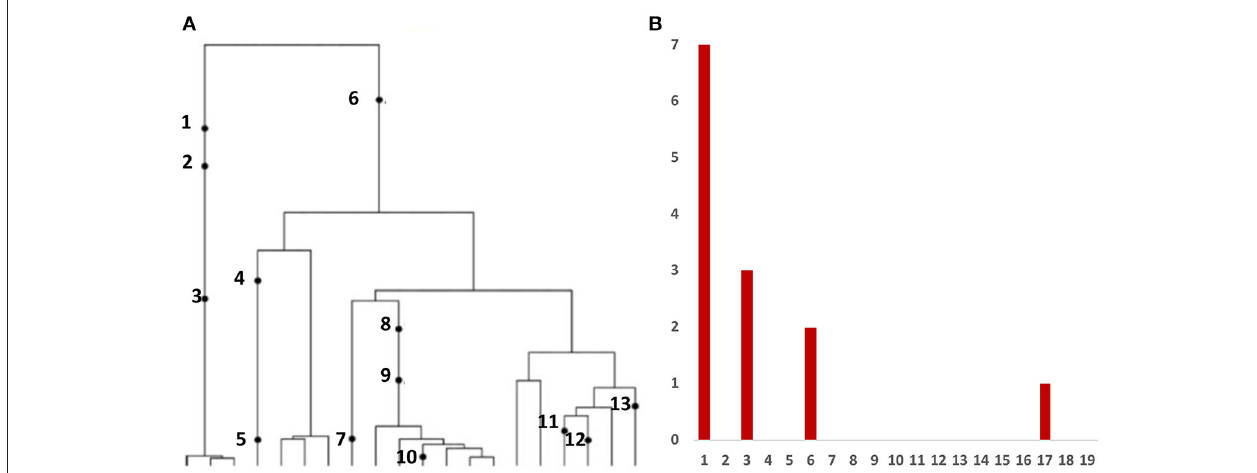
FIGURE 1 | The Site Frequency Spectrum (SFS). (A) Genealogy of a sample of n = 20 cells includes 13 mutational events, denoted by black dots. Mutations 4, 5, 7, 10, 11, 12, and 13 (total of 7 mutations) are present in a single cell, mutations 1, 2, and 3 (total of 3 mutations) are present in three cells, mutations 8 and 9 (2 mutations) are present in six cells, and mutation 6 (1 mutation) is present in 17 cells. (B) The observed site frequency spectrum, S 20 (1) = 7, S 20 (3) = 3, S 20 (6) = 2, and S 20 (17) = 1, other S n ( k ) equal to